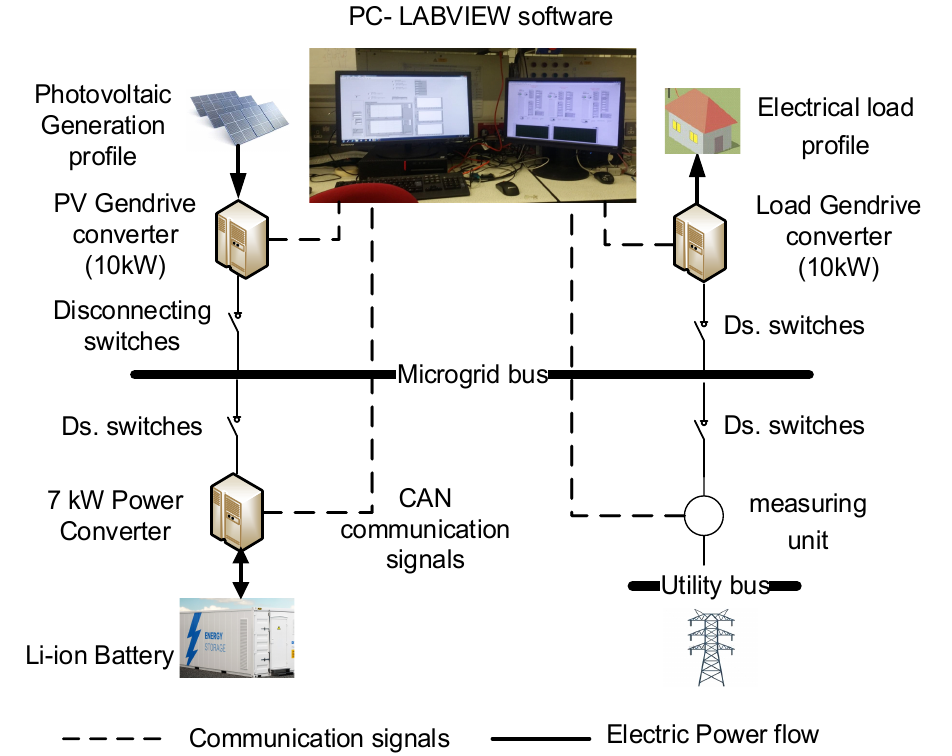
Figure 12. The complete architecture of the microgrid at the University of Nottingham Laboratory.